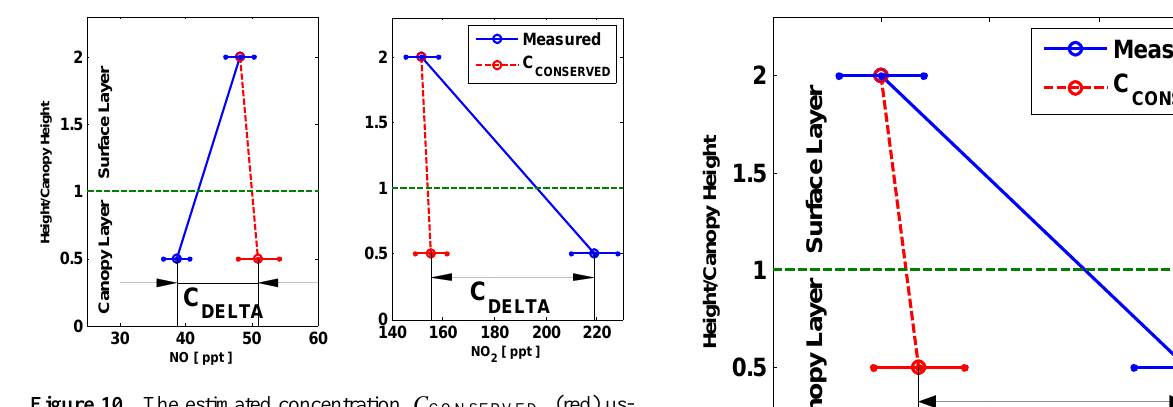
Figure 10. The estimated concentration, C CONSERVED , (red) using standard flux-gradient similarities of NO and NO 2 at midday (12:00-14:00 and the measured vertical gradient (blue), giving values for C DELTA of 12 ppt (NO) and 64 ppt (NO 2 ).